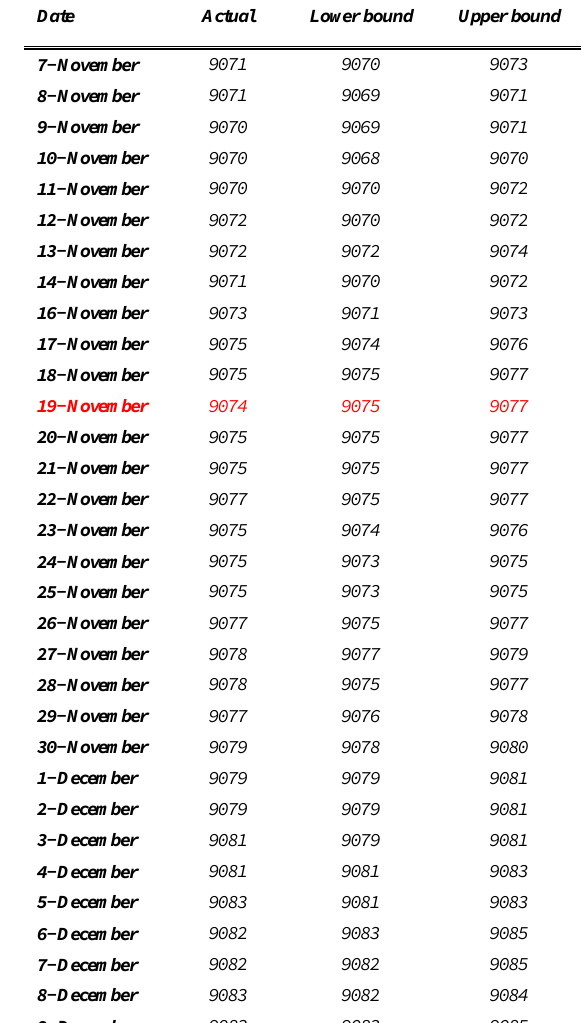
Table 3. Detected subintervals for actual values in the forecasted interval by FARIMA for training data set * . Date Actual Lower